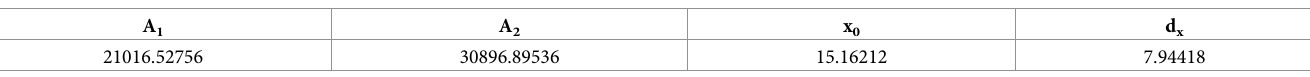
Table 15. Fitting equation parameters of efficiency of